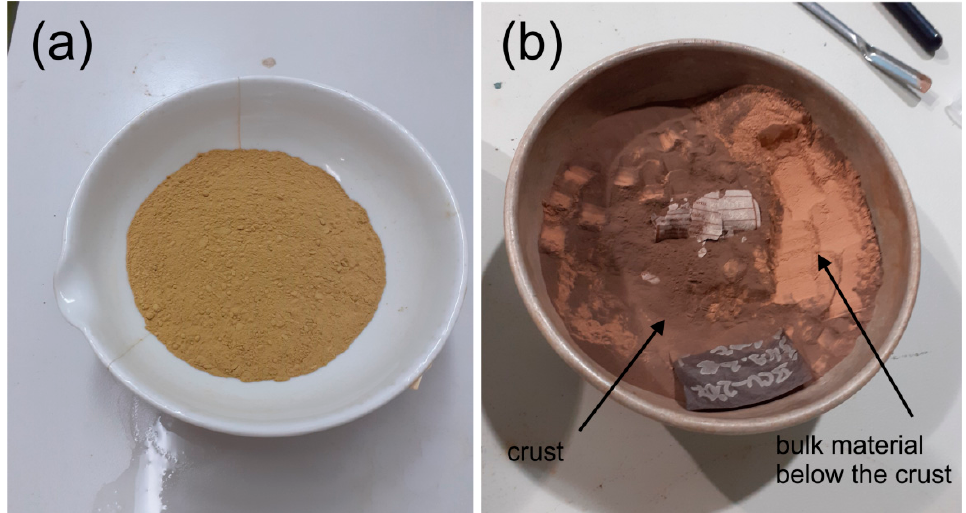
Figure 2. Comparison of ( a ) original and ( b ) thermally treated BCV 2017 at 200° C. Note the presence of a thin dark crust on the surface of the thermally treated material.